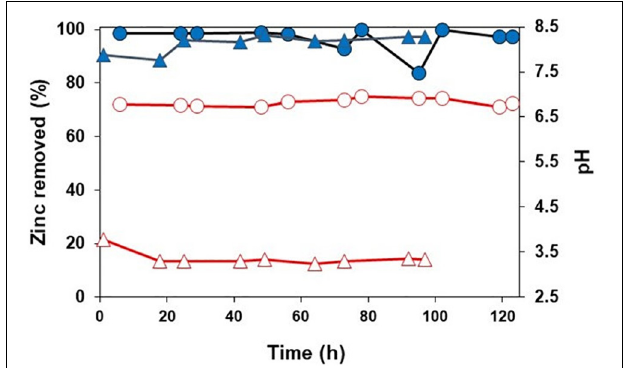
FIGURE 2 | Precipitation of zinc (closed symbols) and changes in bioreactor pH (open symbols) during in-line treatment of synthetic ( (cid:78) , (cid:77) ) and actual MIW ( • , ◦ ) from Minsterley Brook.